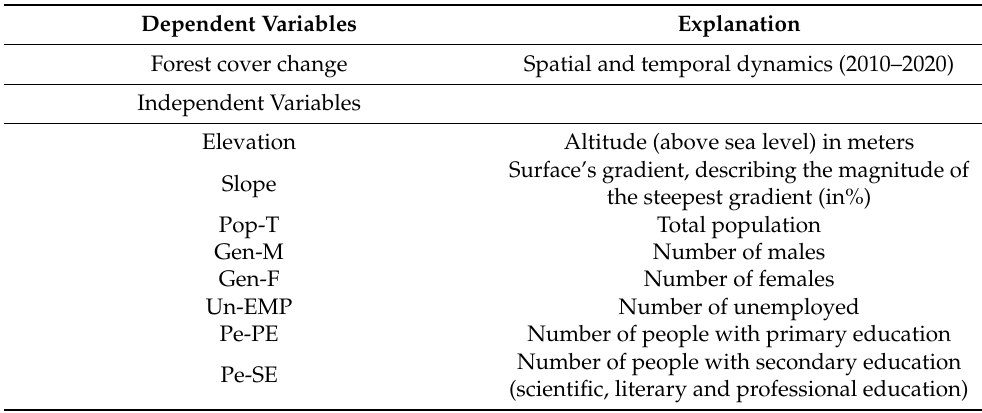
Table 4. A summary of the physical and socio-demographic variables as explanatory variables used in geographically weighted regression for changes tracking in forest cover in the Syrian coast